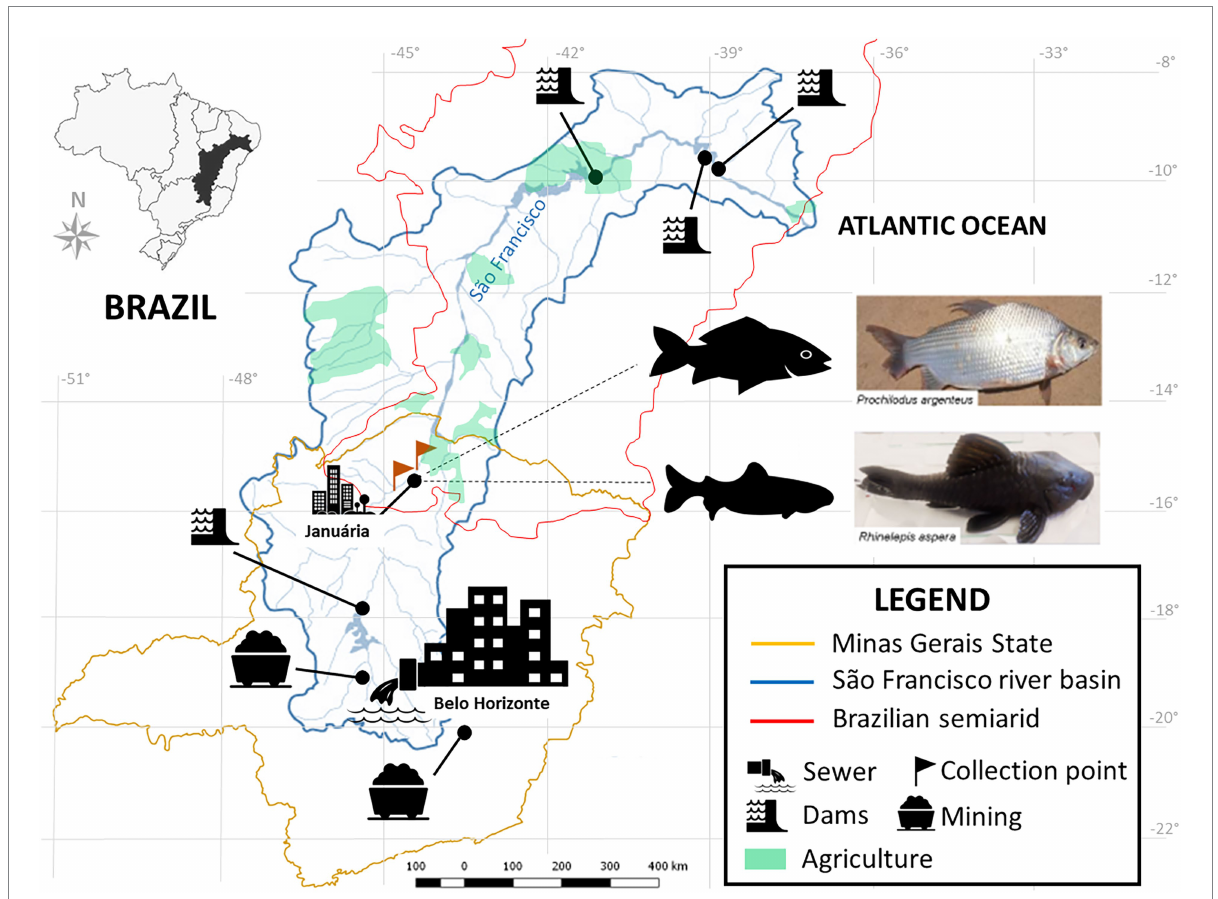
FIGURE 1 Location of the SFR Basin, highlighting the region of collection and the species of ichthyofauna studied. Fish collection site in the middle SFR region, upstream and downstream of the city of Januária, North of Minas Gerais. Brazil. Google. The map was obtained from the Pristine Institute: digital geoenvironmental atlas. WebGis (Web Geographical Information System) with “free access to the environmental database.” Available at <https://institutopristino.org.br/atlas/>. Access on